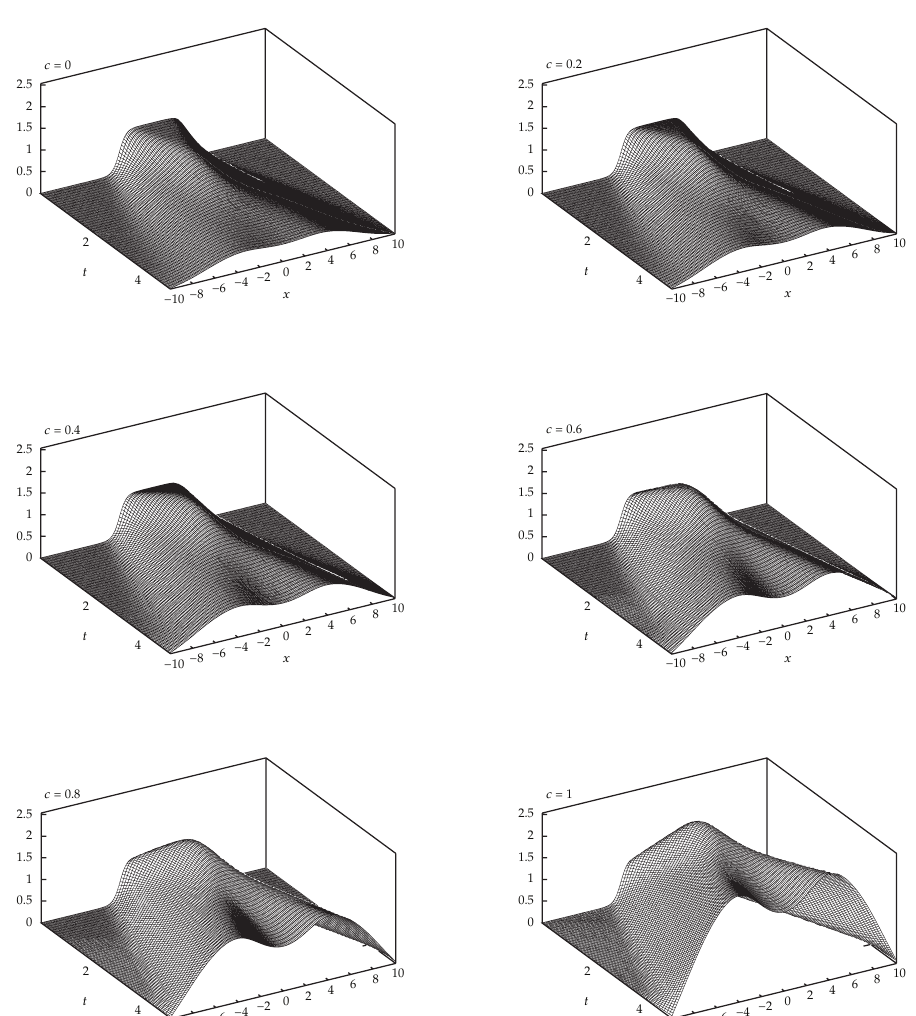
Figure 2: Numerical solution to (cid:4) 1.1 (cid:5) for α (cid:2) 1 . 5, t ∈ (cid:6) 0 , 5 (cid:7) , k ≡ 0, b (cid:4) t (cid:5) (cid:2) c · e − t . fractional value of α (cid:2) 1 . 5, between the pure di ff usion case (cid:4) α (cid:2) 1 (cid:5) and the pure wave case (cid:4) α (cid:2) 2 (cid:5) . For more examples of unperturbed evolution of solutions to (cid:4) 1.1 (cid:5) in two-dimensional case, see (cid:6) 28 (cid:7)